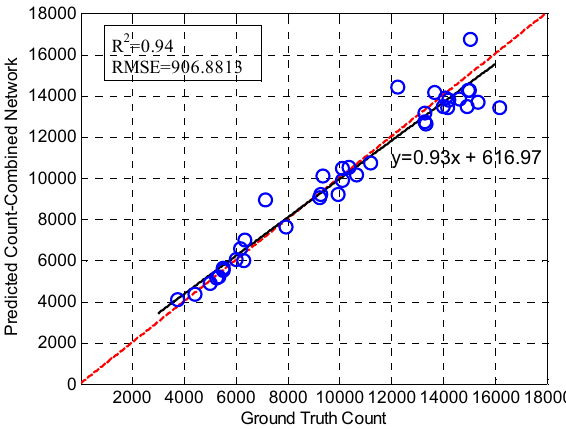
Figure 11. Manual counting versus automatic counting with our Combined Network model. The 1:1